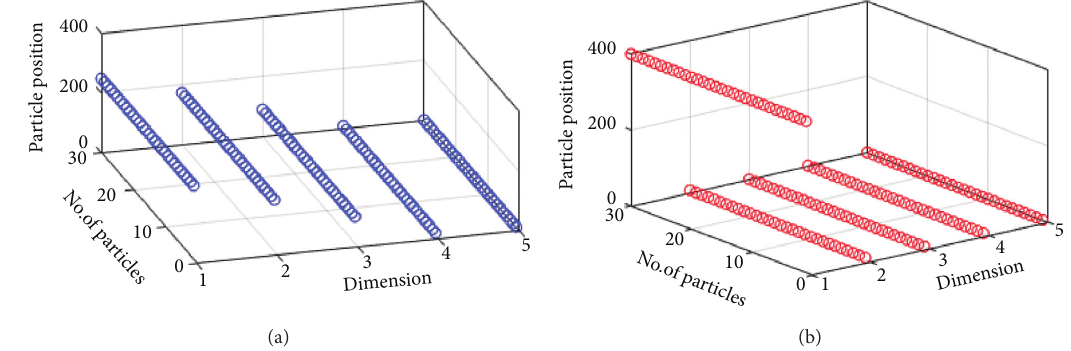
Figure 15: Particle convergence after 500 iterations. (a) PSO. (b) AIWPSO.